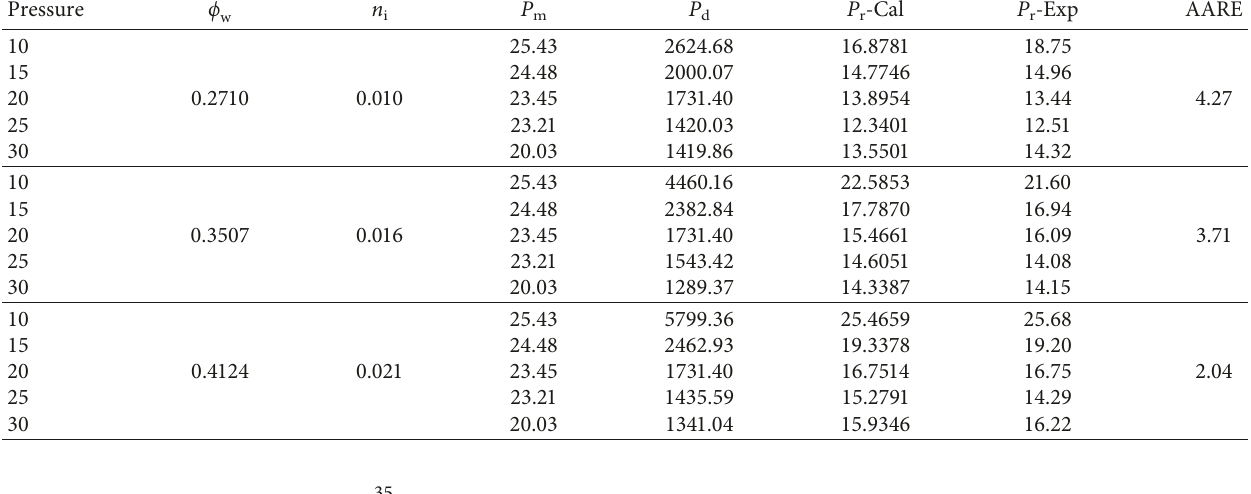
Table 9: P r -calculated and P r -experimental values for CO 2 of IL3M-emim[CF 3 SO 3 ] using the modified MWS model. Pressure